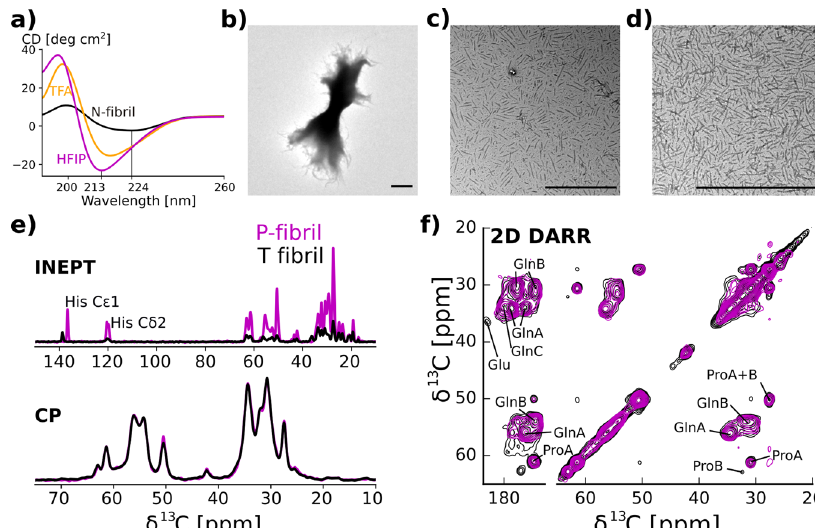
Fig. 6 TFA and HFIP can disaggregate T- fi brils to form highly disentangled P- fi brils. a CD spectra of N- fi brils (black), N- fi brils that were treated with 0.5% TFA in H 2 O (orange), and HFIP (purple). The minima of the spectra treated with 0.5% TFA and HFIP are increasingly blue shifted and show an increase in apparent circular dichroims likely due to a decrease in scattering. b EM of highly bundled N- fi brils before HFIP treatment. c EM of same fi brils after HFIP treatment showing the presence of highly unbundled proto fi brils. d EM of T- fi brils after HFIP/TFA treatment. Scale bars for ( b ) – ( d ) denote 1 μ m. e 1D 13 C spectra of HTTex1(Q46) P- and N- fi brils are shown in violet and black, respectively. CP spectra were normalized to their Gln C α intensities. The close to perfect overlap of the CP spectra indicates that the static core of these two fi bril types is very similar. Refocused INEPT spectra were normalized according to the CP spectra. His side chain carbon resonances are indicated. The much higher relative intensity of the INEPT spectra of the P- fi brils indicates that the PRD is more dynamic. The shift in the His C ε 1 line re fl ects the low pH used for the proto fi bril preparation. f Overlap of 2D DARR 13 C- 13 C spectra of HTTex1 (Q46) P- fi brils (violet) and T- fi brils (black) indicates that the static fi bril core of both fi brils has a very similar structure. Both spectra were recorded at 0 °C, 25 kHz MAS with 50 ms mixing time. The spectrum of the 4°C fi brils was previously published as Fig. 2 by Isas et al. 8